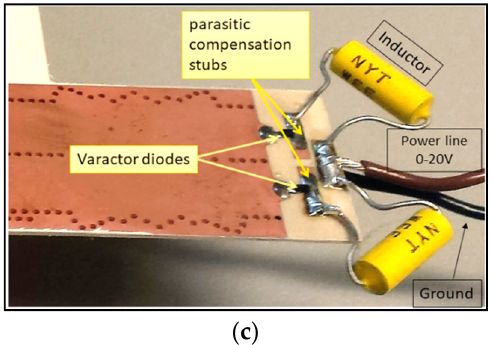
Figure 14. Beam steering antenna system prototype, ( a ) top view, ( b ) bottom view, ( c ) details of the phase shifter circuit.